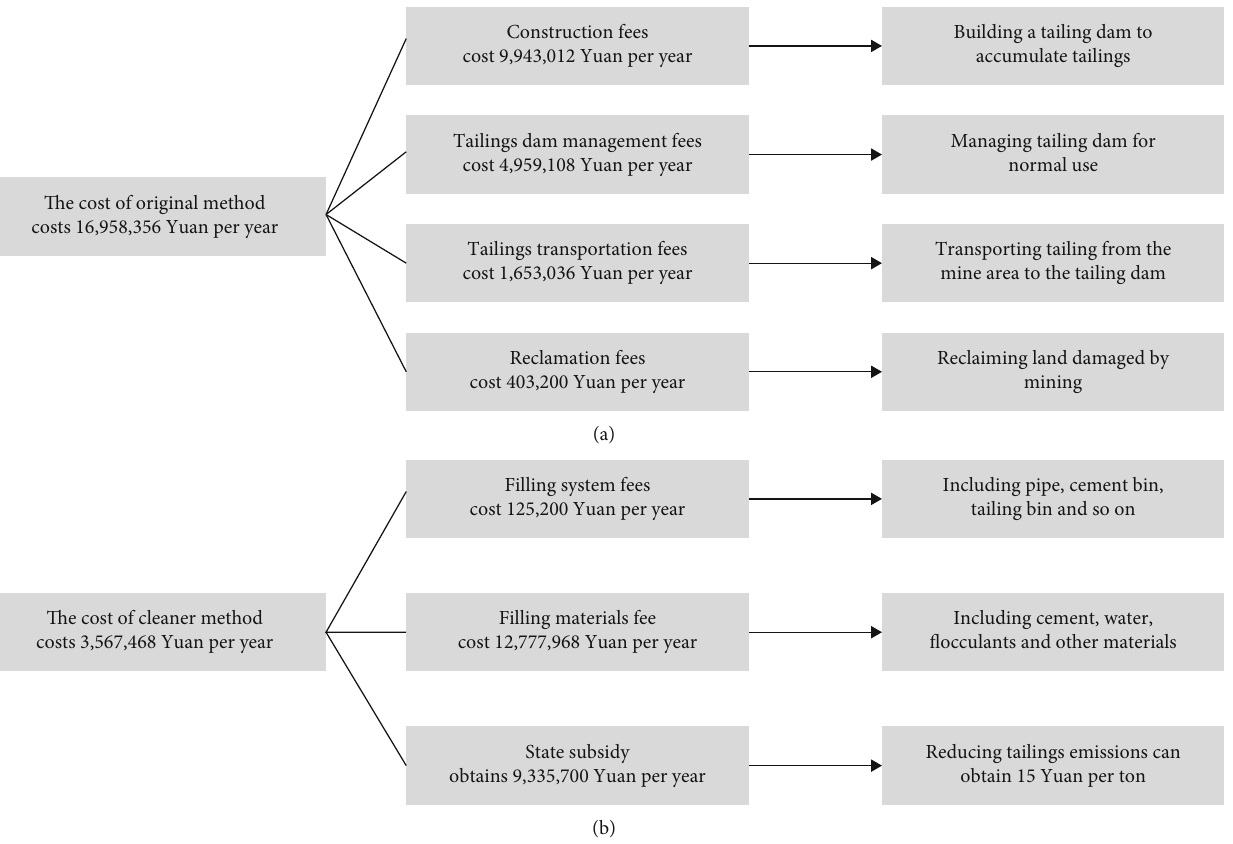
Figure 11: (a) The cost of original method and (b) the cost of cleaner